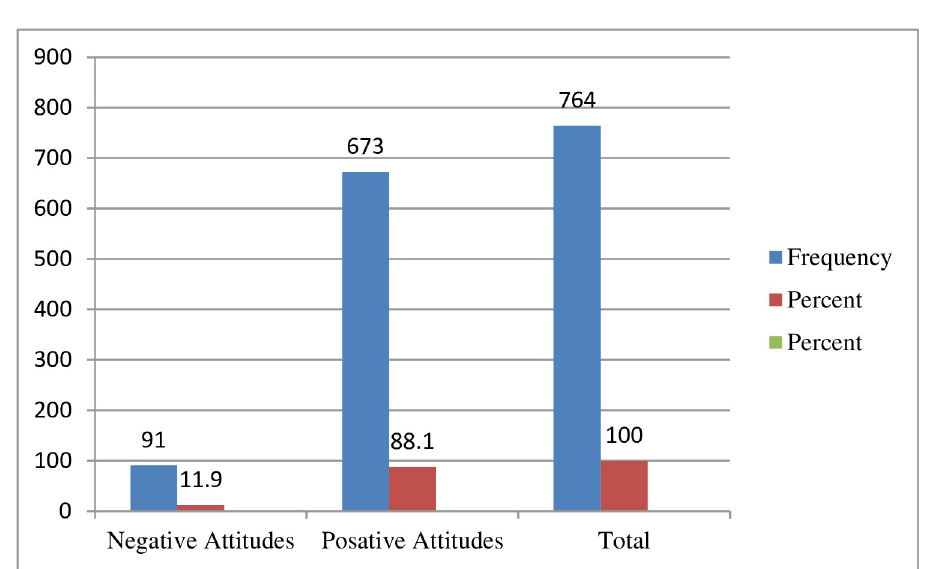
Fig 3. Attitude-related questioner respondents on about knowledge, attitudes, and practices of face mask utilization and associated factors in COVID-19 pandemic among Wachemo university students, southern Ethiopia: February to March 2021 (n = 764).